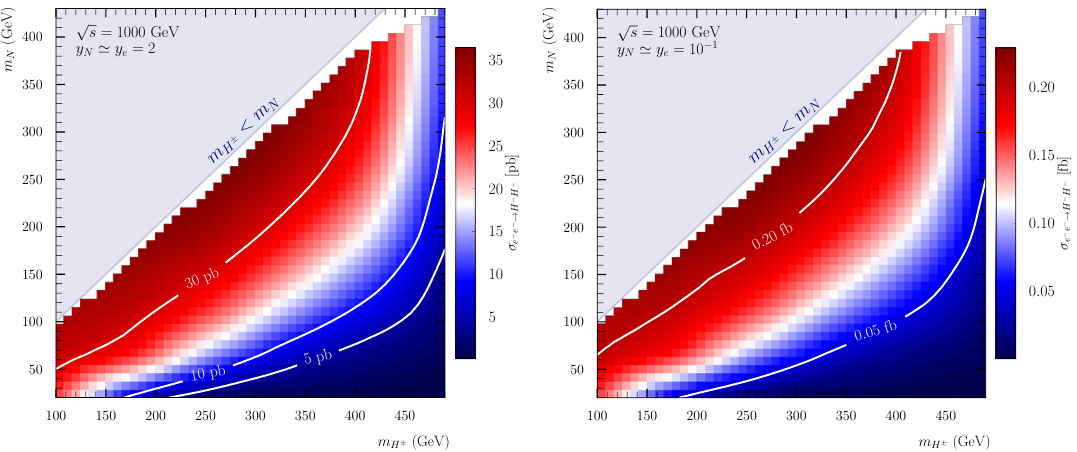
Figure 6 . Production cross sections for same-sign charged Higgs pair production in e − e − collisions √ at s = 1000 GeV for y N ’ y e = 2 (left panel) and y N ’ y e = 10 − 1 (right